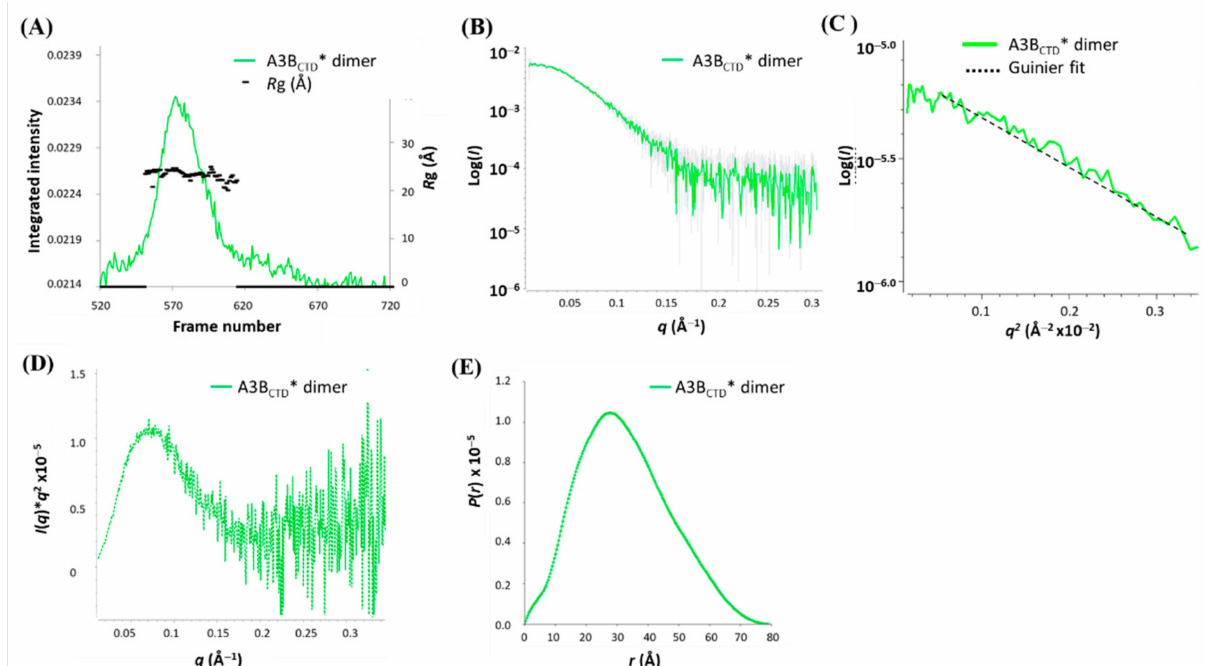
Figure 8. SEC-SAXS analysis of A3B CTD * dimer. ( A ) SAXS profile plot. ( B ) scattering curve. ( C ) Guinier plot. ( D ) Kratky plot. ( E ) P ( r ) distribution plot. Experiments were conducted using 2.5 mg/mL of A3B CTD * dimer in pH 5.5 buffer (see caption to Figure